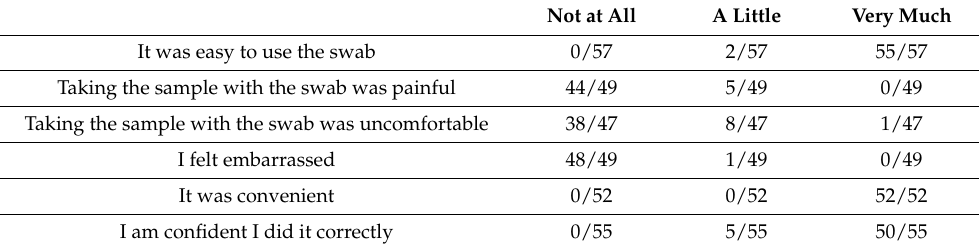
Table 3. Participant responses to using the